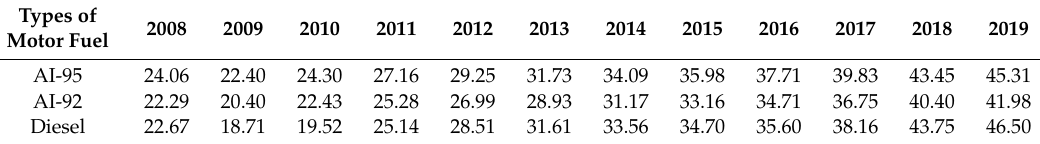
Table 5. Average consumer prices for motor fuels (rouble per litre) in Russia (data from